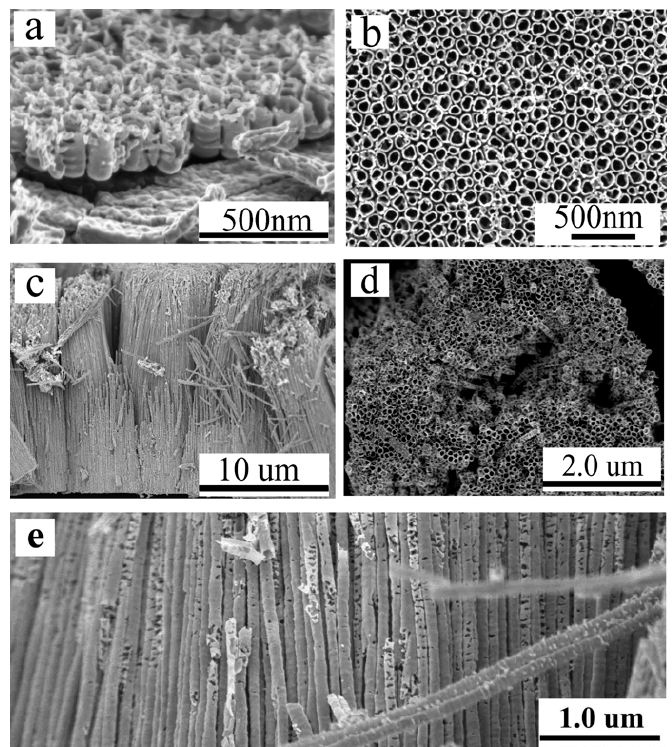
Figure 9. Cross-sectional and top-view images of TiO 2 nanotube arrays prepared by anodizing Ti foil at 20 V in 0.5 wt.% HF (Hydrofluoric Acid) aqueous solution for 20 min ( a , b ) and in formamide-based electrolyte for 6 h ( c – e ). Reprinted from [16], Copyright 2020, American Chemical